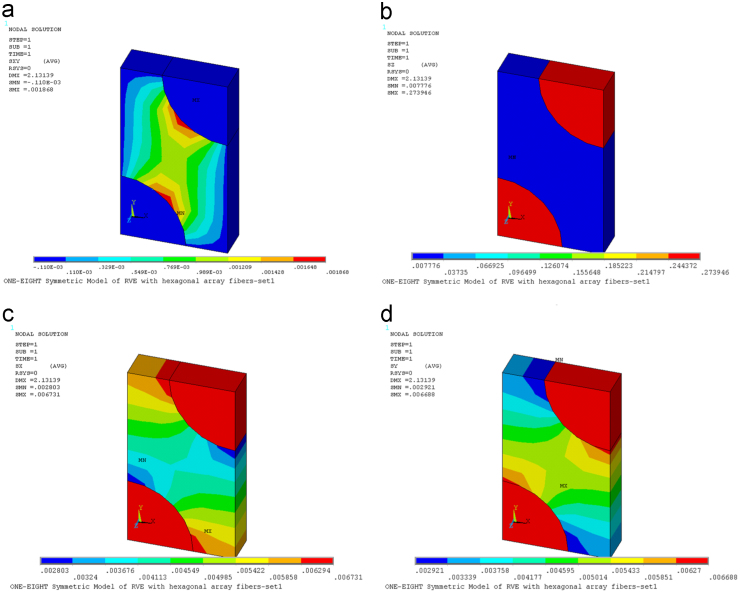
(a) Contour plot of stresses τxy on deformed RVE [TPa]. (b) Contour plot of stresses σz on deformed RVE [TPa]. (c) Contour plot of stresses σx on deformed RVE [TPa]. (d) Contour plot of stresses σy on deformed RVE [TPa].